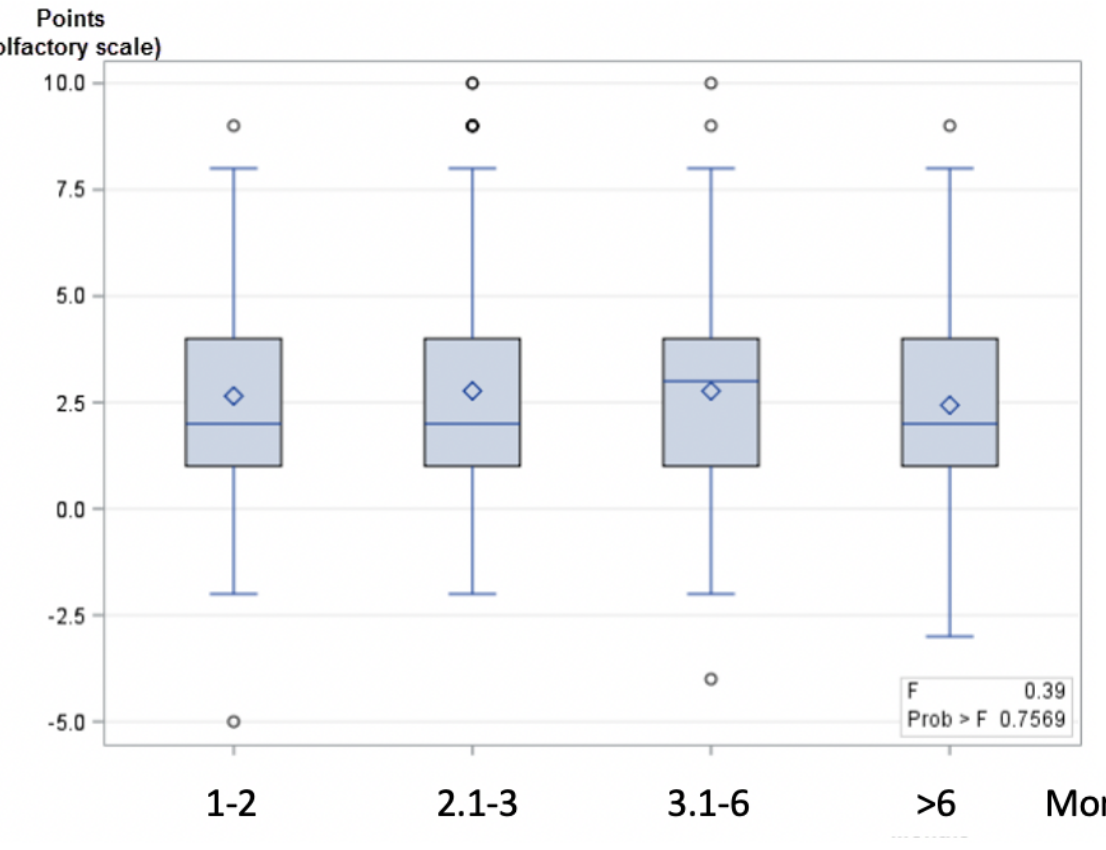
Figure 3. Mean improvement of olfactory function stratified by the duration of persistent olfactory dysfunction. Improvement was assessed with a self-assessed olfactory scale of 0-10 after olfactory